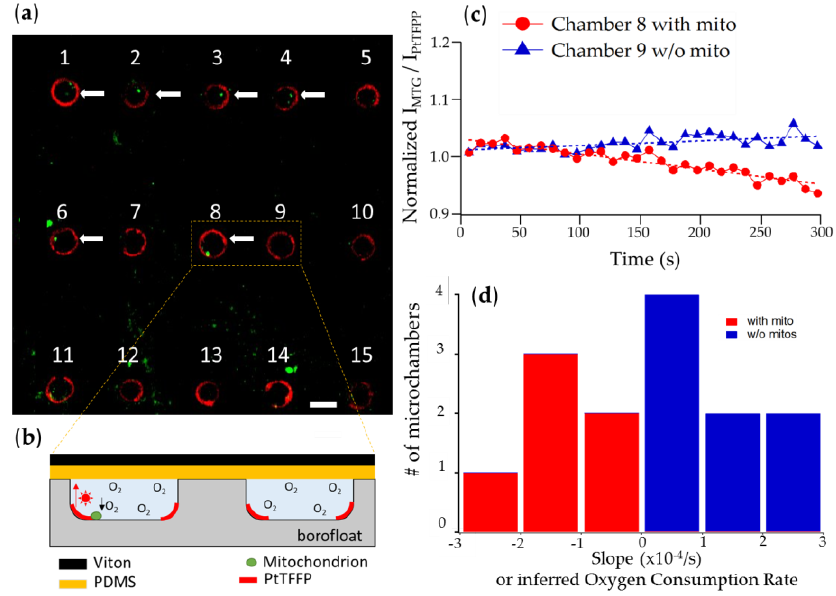
Figure 3. ( a ) Up to 15 microchambers could be viewed in the same field of view. After mitochondria deposition and Viton-PDMS sealing, some microchambers contained mitochondria (indicated by the white arrows) and others did not. Scale bar is 15 µm; ( b ) Zoomed in, side-view cartoon of chambers 8 and 9; ( c ) Normalized intensity (radiometric measurement divided by the initial measurement) measurement of a representative microchamber with mitochondria and another chamber without mitochondria. The result for chamber 8 indicates a gradual decrease in signal signifying a depletion of oxygen while the result for chamber 9 displays a small positive slope probably due to unaccounted photobleaching. Data points were averaged every 10 s; ( d ) The histogram showing the calculated slopes of the measured intensities from chambers 1 to 14. Chambers 1, 2, 3, 4, 6, 8 were the ones with mitochondria. Chamber 15 was not included in the analysis due to insufficient signal readout. The slopes are directly related to the oxygen consumption rates.